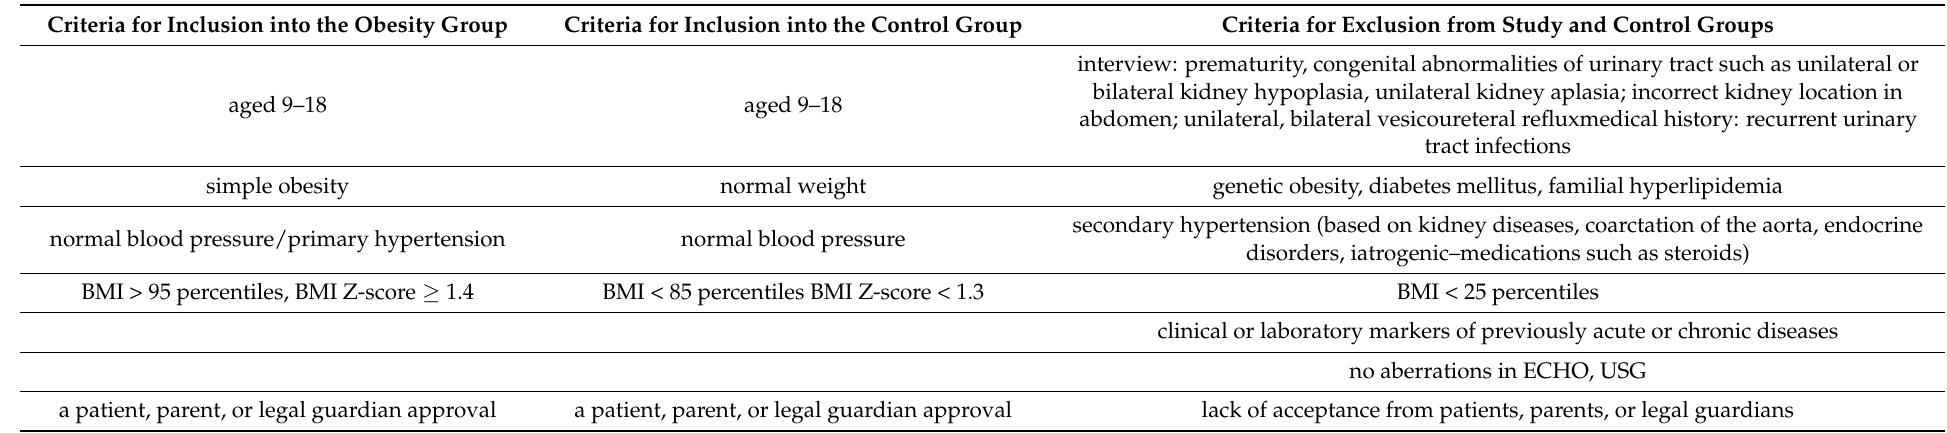
Table 1. Inclusion and exclusion criteria for study and control